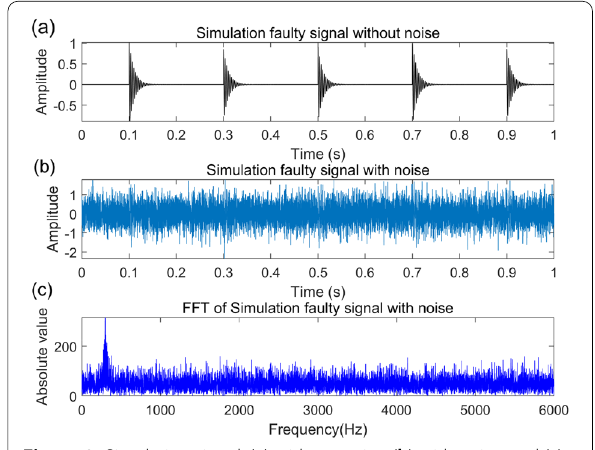
Figure 2 Simulation signal: ( a ) without noise, ( b ) with noise, and ( c ) the FFT of the simulation